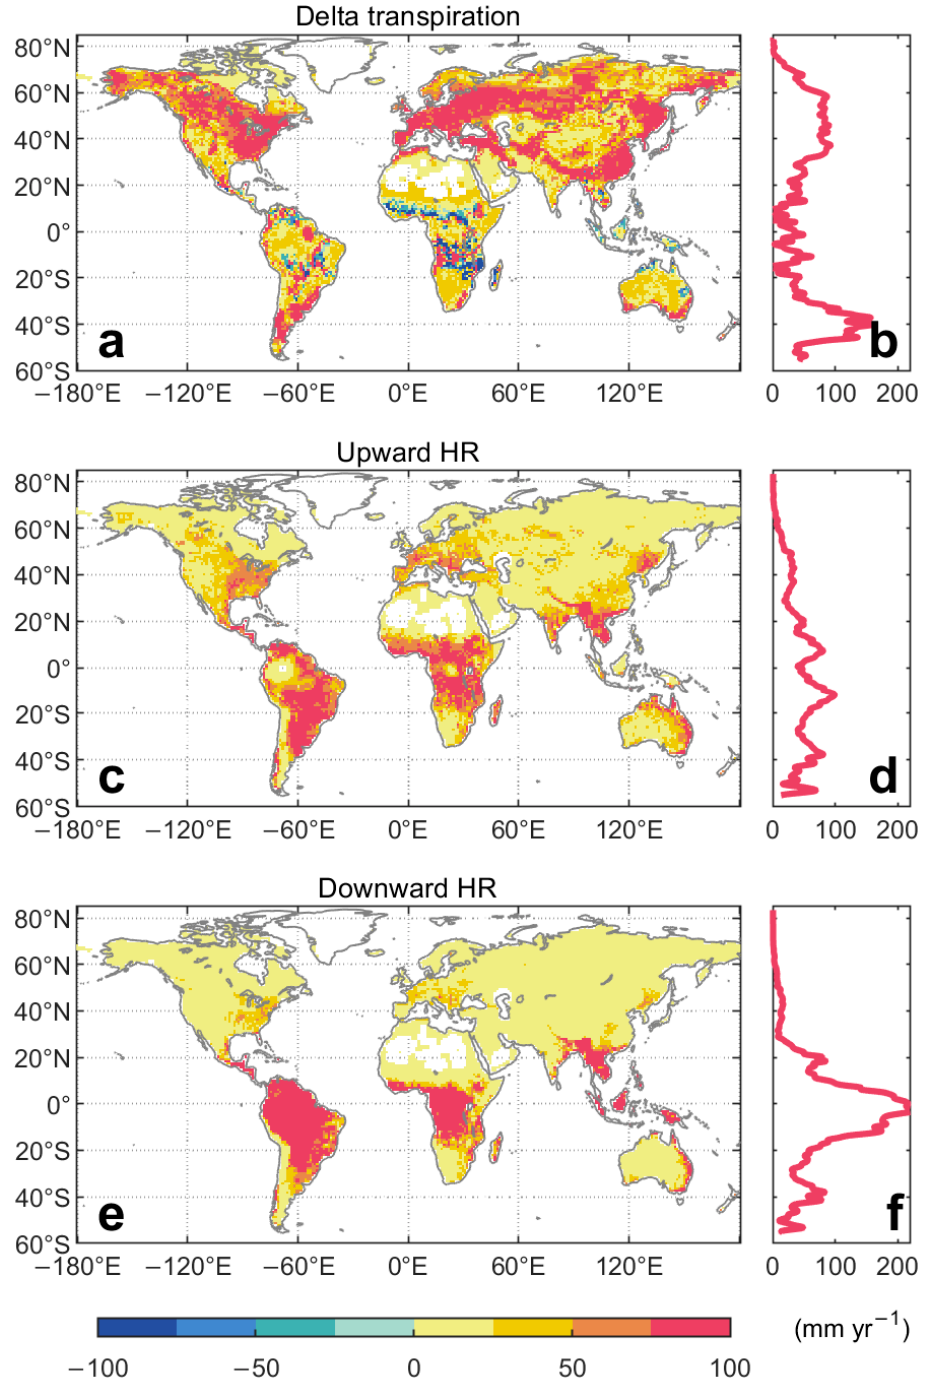
Figure 2. Spatial distributions of the PHS-induced (Delta) plant transpiration change and hydraulic redistribution (HR) of soil water by roots. The pixels in the left panels ( a , c , e ) represent temporally averaged values during 1850–2010 and the vertical thick lines in ( b , d , f ) represent the latitudinal mean of values in corresponding left panels.